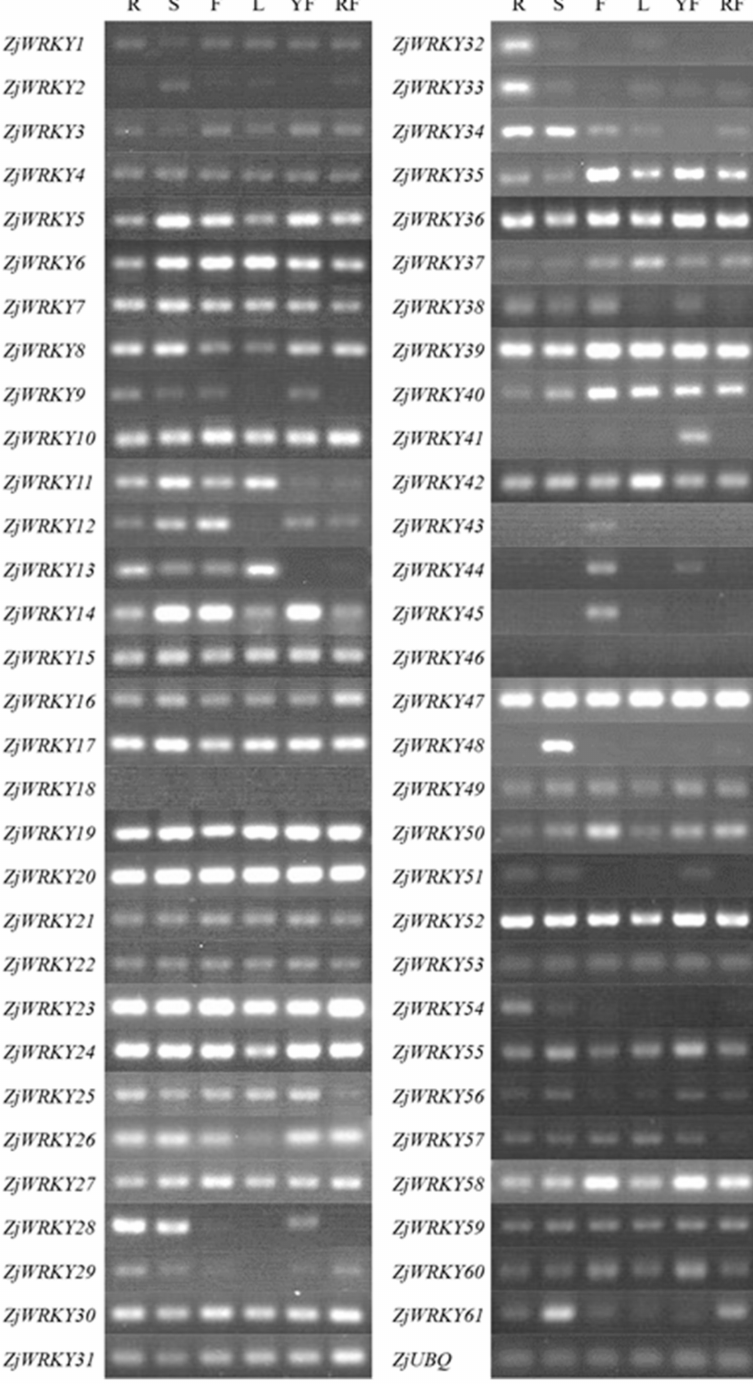
Figure 6. RT-PCR analysis of ZjWRKY genes in six types of tissues / organs of ‘Junzao’ jujube. R: root; S: stem; F: flower; L: leaf; YF: young fruit; and RF: ripe